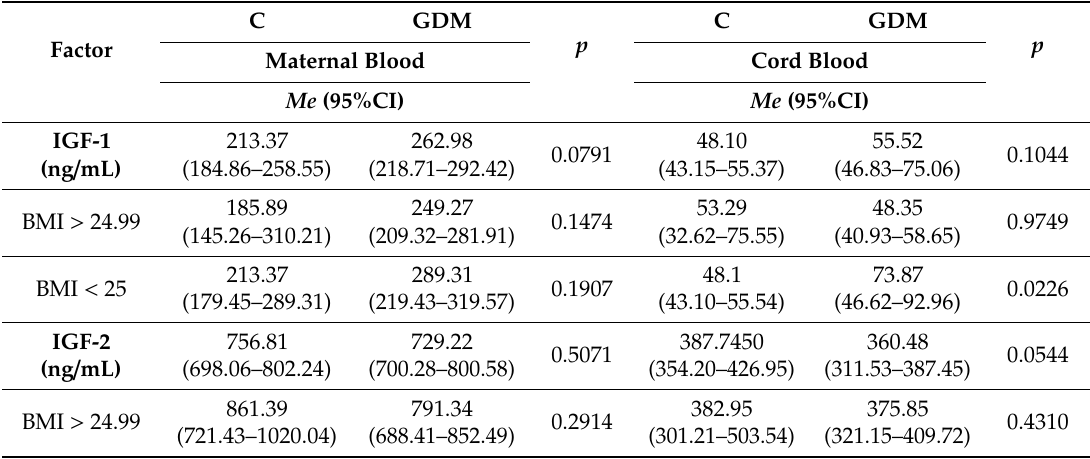
Table 2. A comparison of the examined parameters in the peripheral blood of both women with GDM and healthy women (C), as well as in umbilical cord blood of newborns delivered by women with GDM and by healthy mothers